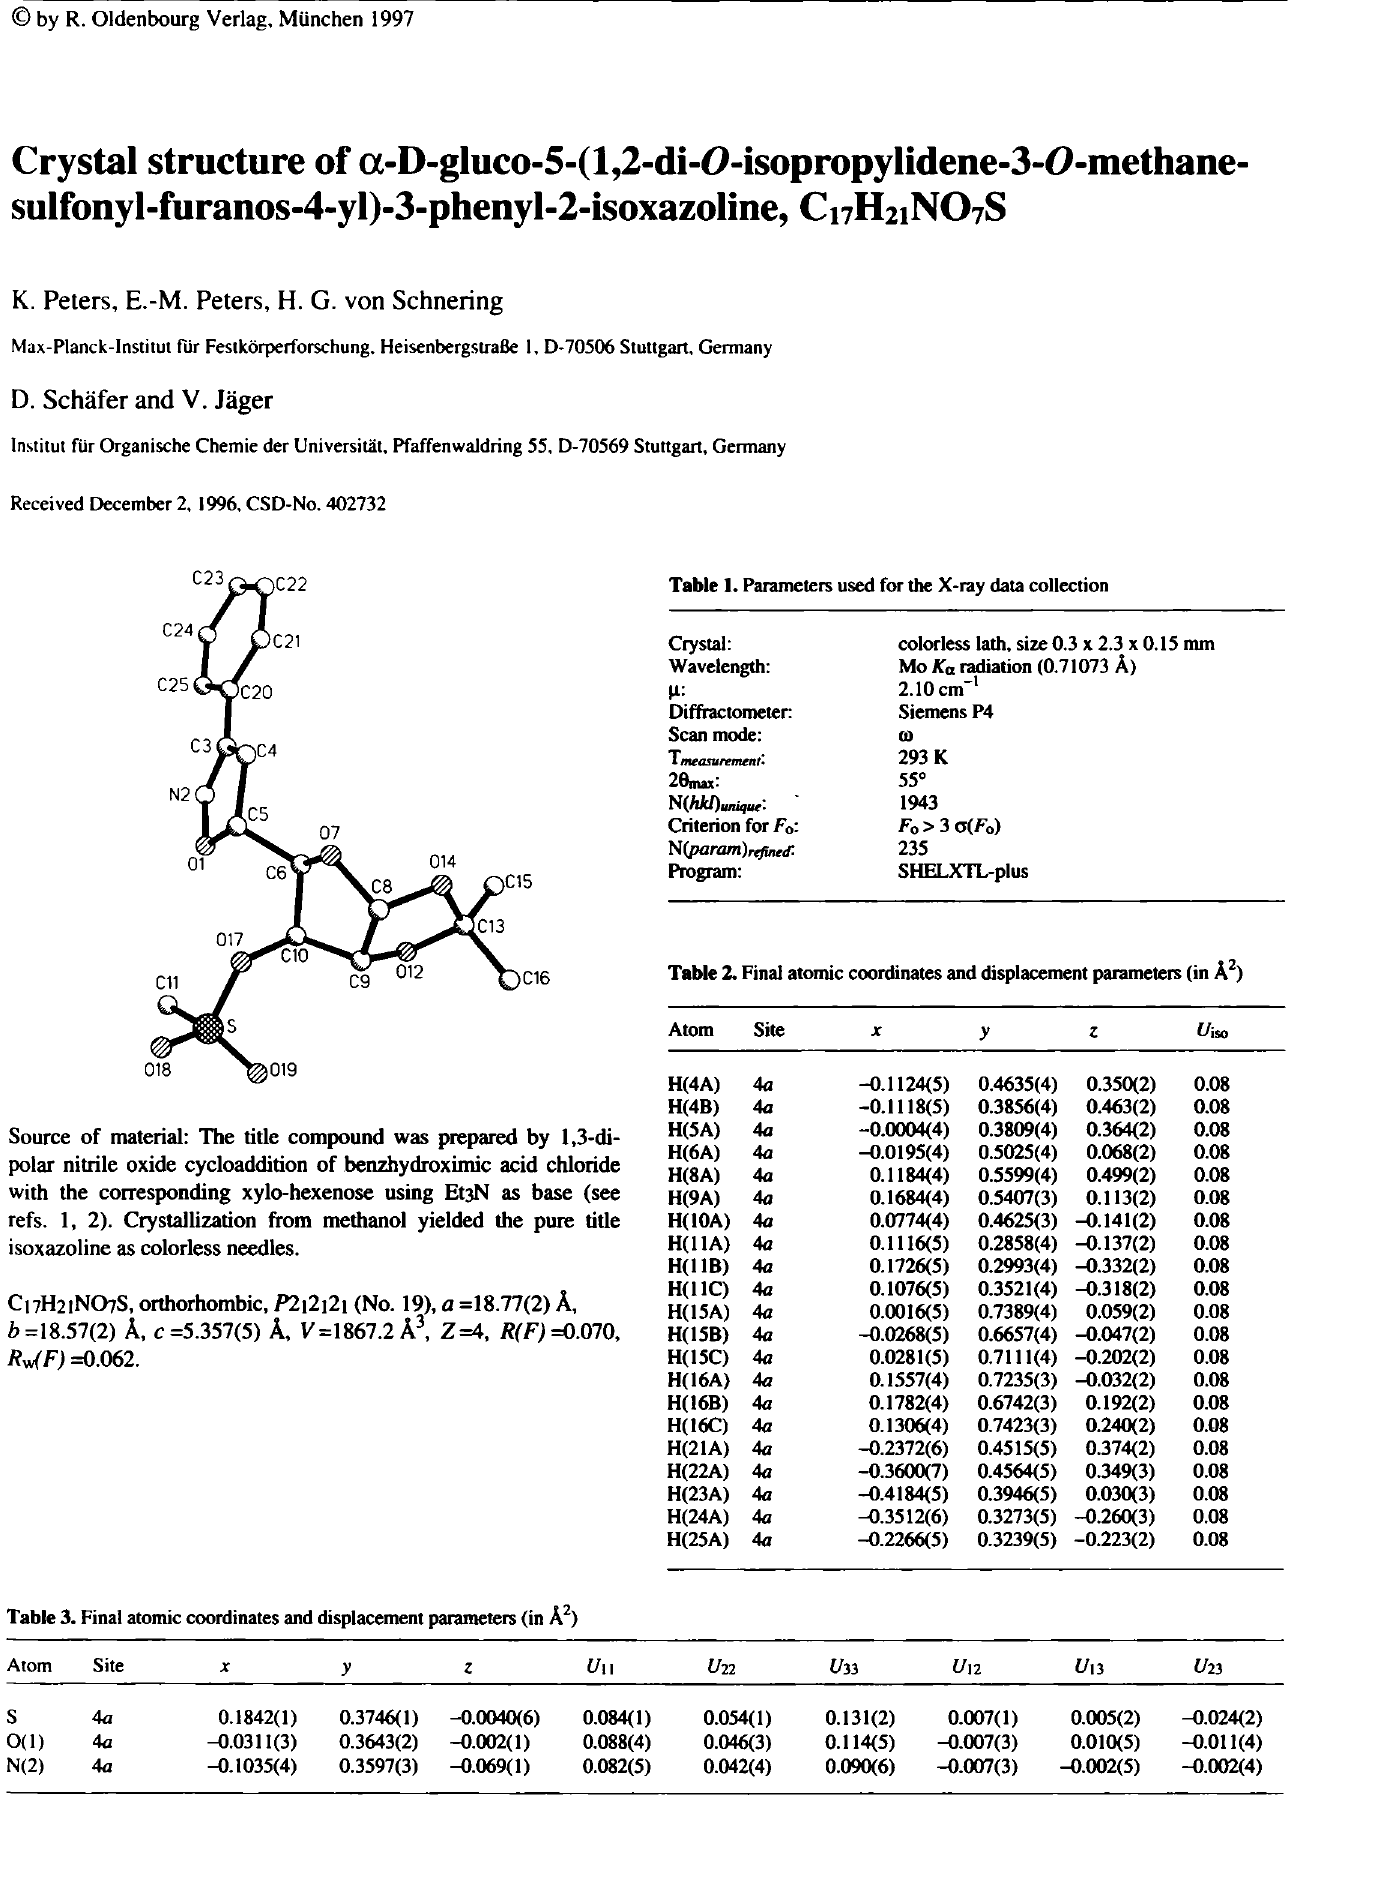
Table 3. Final atomic coordinates and displacement parameters (in Ä 2